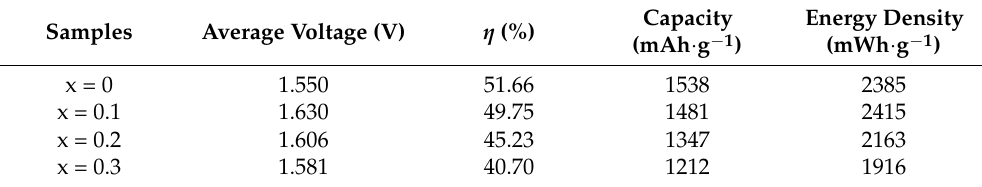
Table 5. The electrochemical parameters of the AABs using the Al-1Zn-0.1In-0.1Sn-0.5Mg-xMn (x = 0, 0.1, 0.2, 0.3) (wt.%) alloy anodes discharged at 20 mA · cm − 2 current density for 4 h in the 4 M NaOH solution.